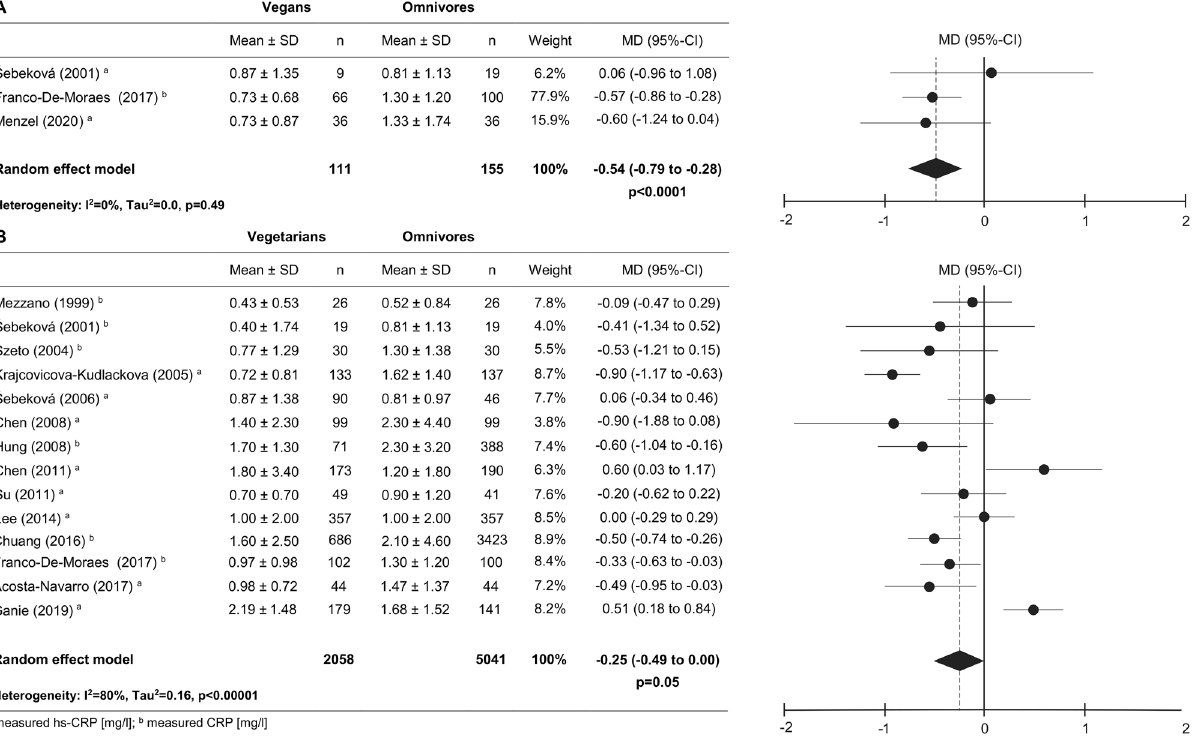
Figure 2. Forest plots of the effect of a vegan and vegetarian diet on CRP concentrations compared to omnivorous diet in apparently healthy participants. Forest plot showing the overall effect of a vegan diet ( A ) or a vegetarian diet ( B ) on CRP concentrations compared to omnivorous diet in apparently healthy participants. Results are presented as mean difference (MD) (95%-CI). The study-specific MD and 95%-CI are represented by the black dot and horizontal line, respectively. The center of the diamond and the vertical dashed line represent the overall effect size of all studies; the width of the diamond represents the overall pooled